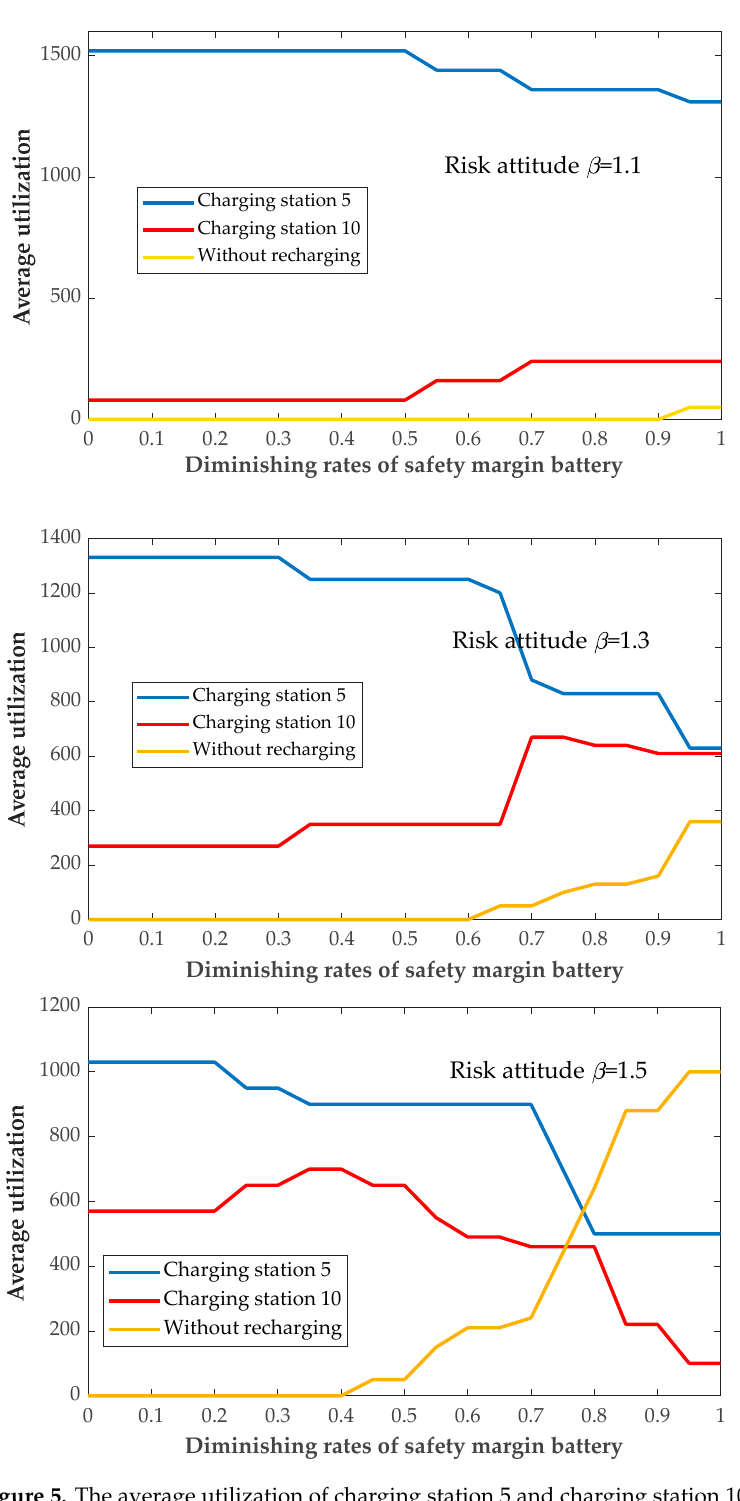
Figure 5. The average utilization of charging station 5 and charging station 10.